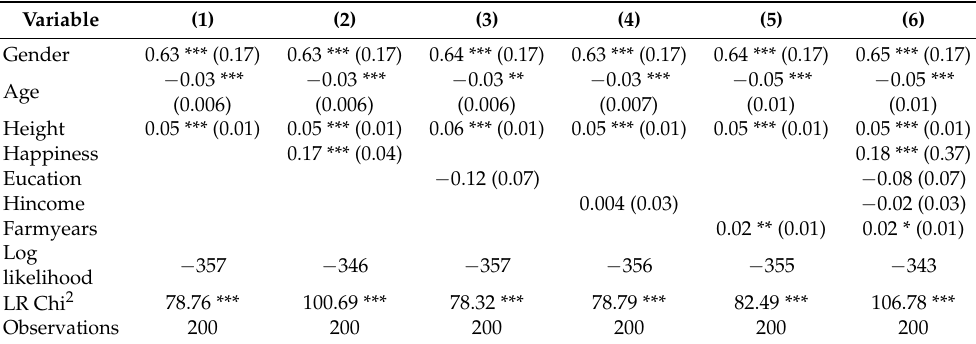
Figure 1. Histogram of responses to the question about willingness to take risks “in general”, measured on a 11-point scale (0 = not willing to take any risks; 10 = fully prepared to take risks). Table 3. Primary determinants of general risk attitudes.